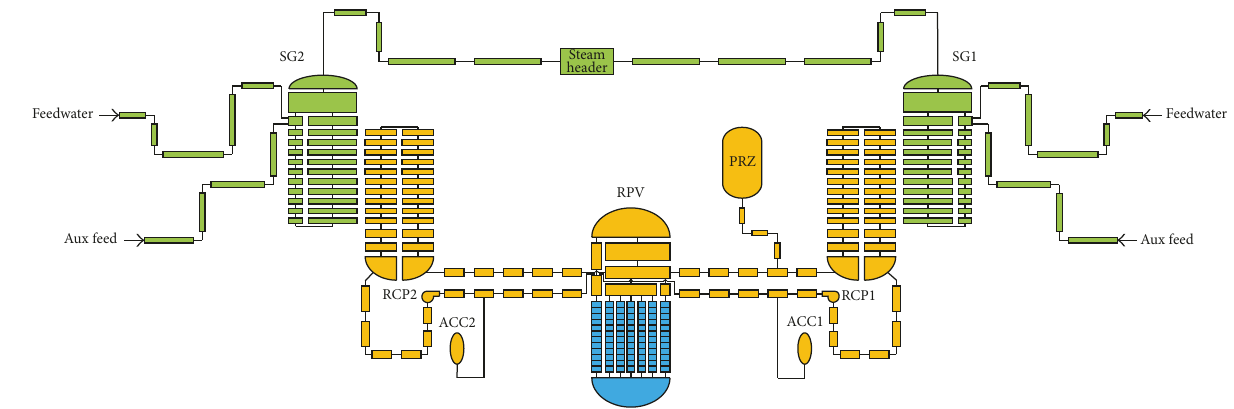
Figure 2: ASTEC and MELCOR nodalization schemes of the primary and secondary